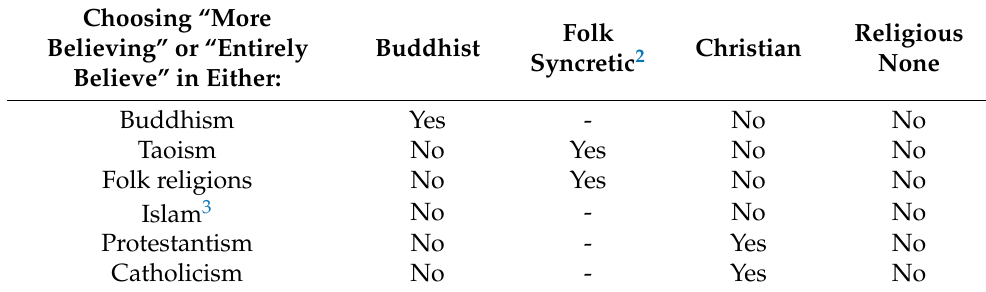
Table 1. Construction of religious